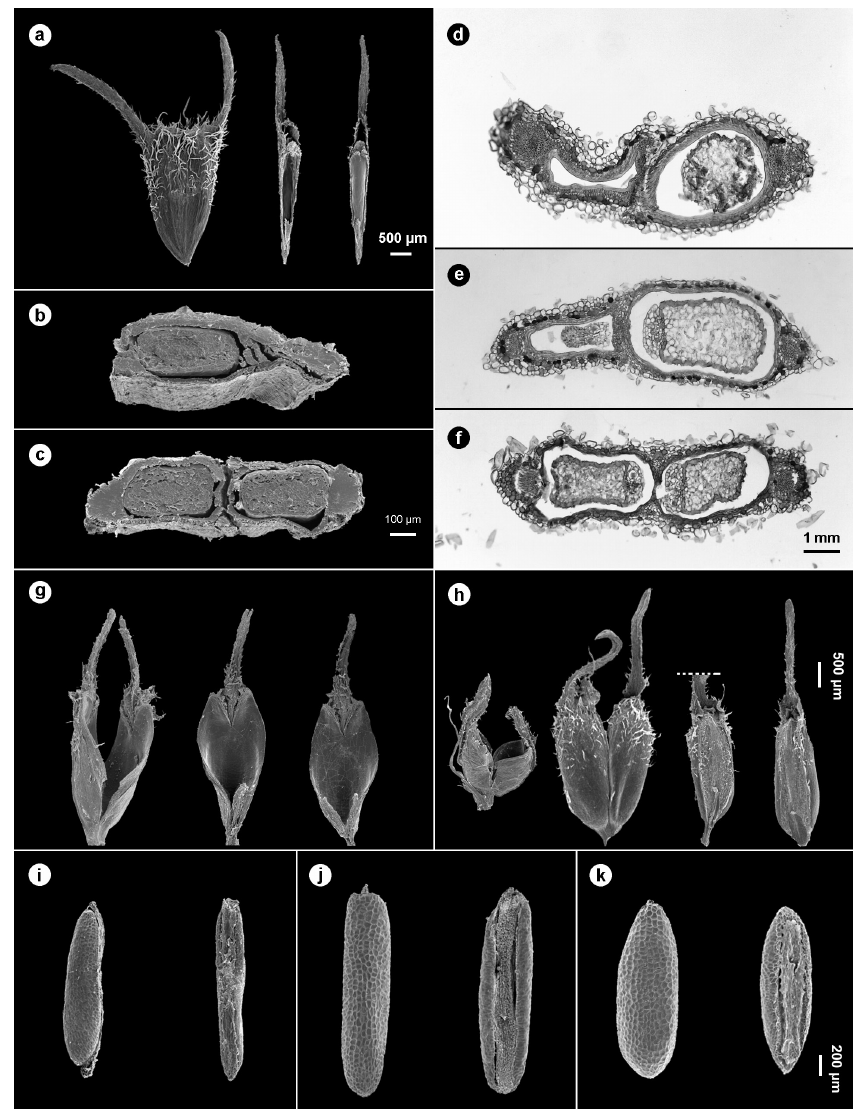
Figure 4 - Fruit and seed morphology. a - h . Fruits. a - f . Diacrodon compressus, a . Fruit and indehiscent valves; b . Cross section of a fruit with one seed (SEM); c . Cross section of a fruit with two seed (SEM); d . Cross section of fruit with one seed (MO); e . Cross section of fruit with a mature seed and with an aborted seed (MO); f . Cross section of fruit with two seeds (MO); g . Borreria spinosa, Fruit and valves, both dehiscent; h . Borreria verticillata, Fruits and valves. Note the dehiscence pattern variation of the valves; i - k . Seeds. i . Diacrodon compressus, lateral and narrowly elliptic ventral view. Note the lateral compression of the seed and the narrowly groove; j . Borreria spinosa , dorsal and elliptic to obovate ventral view. Note the wide groove; k . B. verticillata , dorsal and obovate ventral view. Note the wide